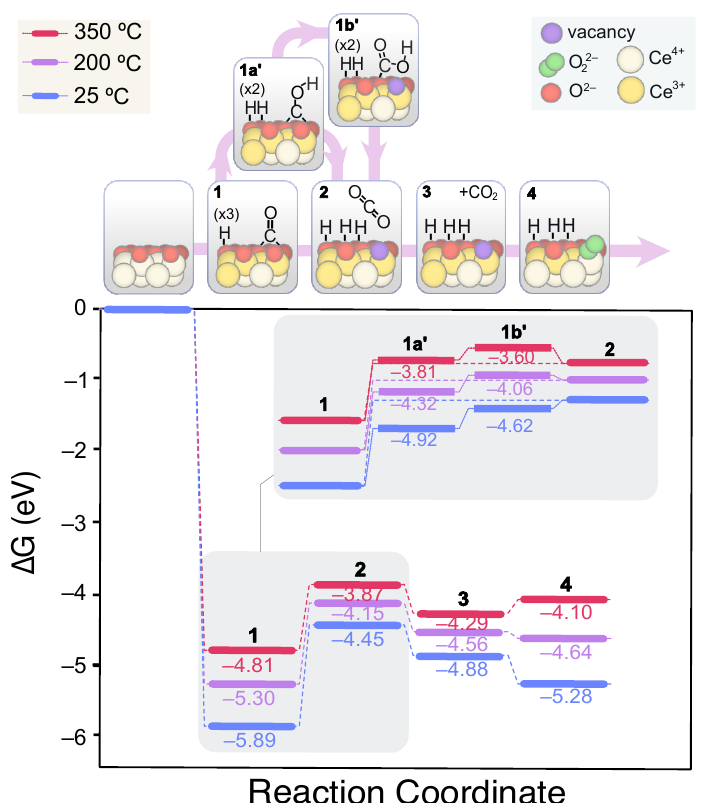
Figure 8. Calculated Gibbs energy diagram for the CO oxidation mechanism on a stoichiometric CeO 2 (110) surface covered with 3 OH groups at different experimental temperatures. The structures of the different reaction intermediates are depicted at the top of the